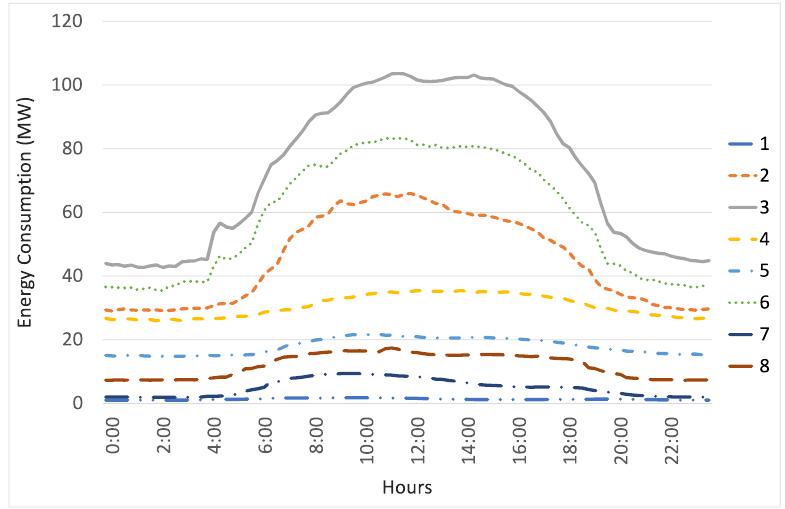
Figure 6. Centroids of the electricity consumption clusters.